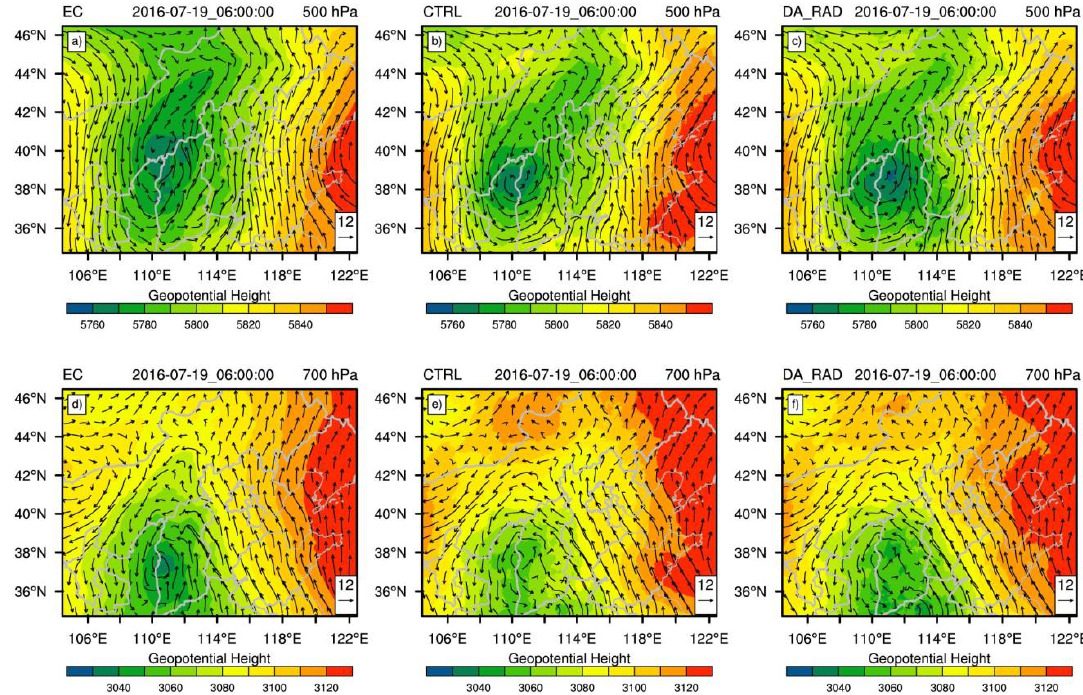
Figure 14. Geopotential height (shaded; m) and wind fields from the forecasts of CTRL and DA_RAD, initialized at 1800 UTC 18 July 2016, for ( a – c ) 500 hPa and ( d – f ) 700 hPa. The corresponding fields from ( a , d ) EC are used for comparison.